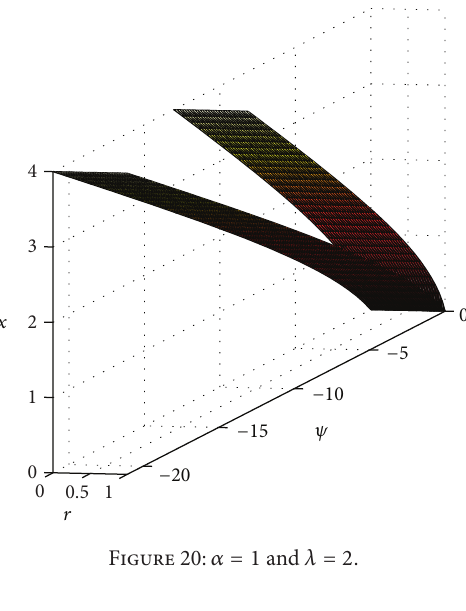
Figure 20: 𝛼 = 1 and 𝜆 = 2